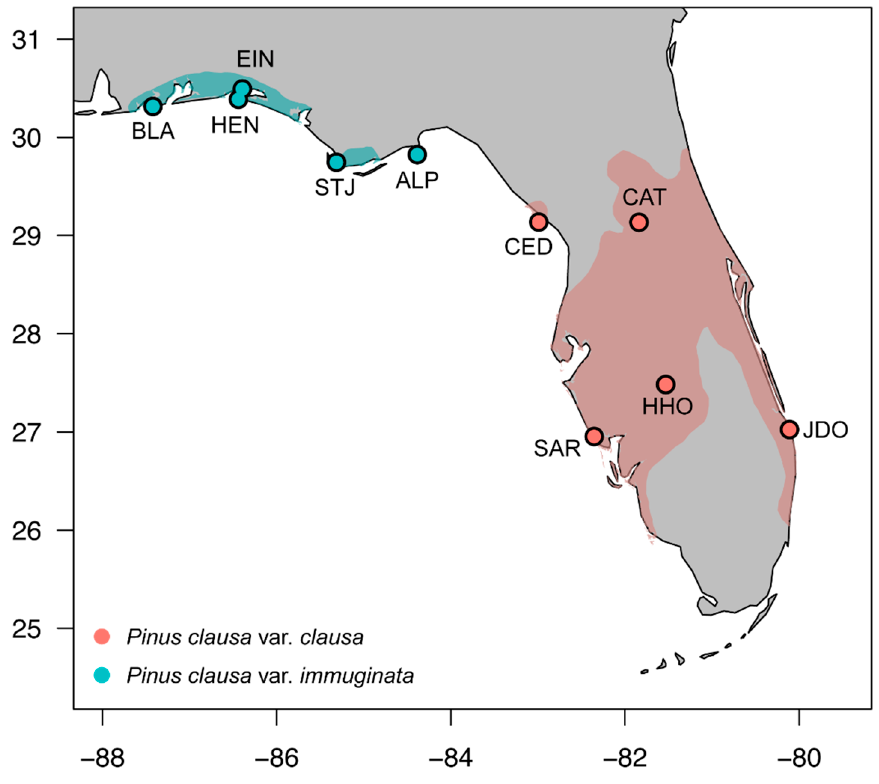
Figure 1. Range map of Pinus clausa sourced from [28] with the location of study stands. Site abbreviations and descriptions can be found in Table 1.